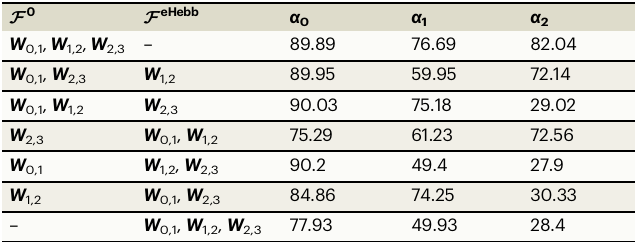
Table 1 | Effect of the Hebbian-like error learning rule F eHebb on the alignment of the modulating signals α ℓ for different layers